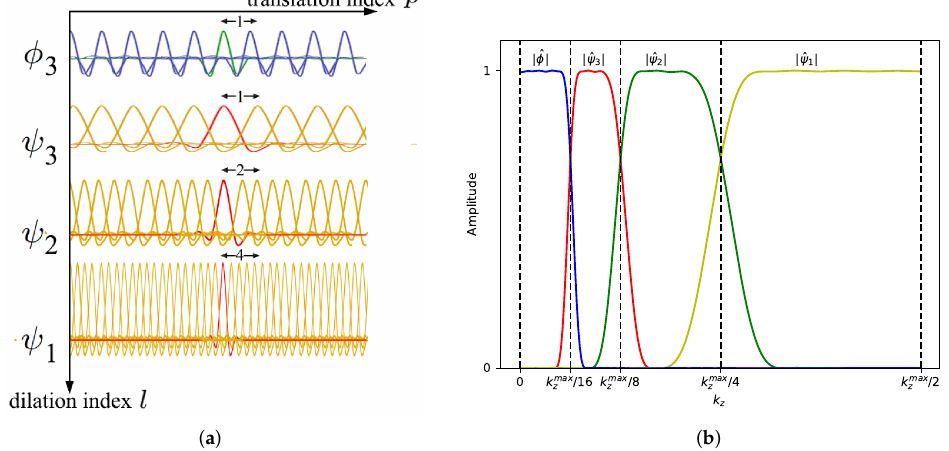
Figure 1. Example of a wavelet basis. ( a ) In the spatial domain. ( b ) Spectral